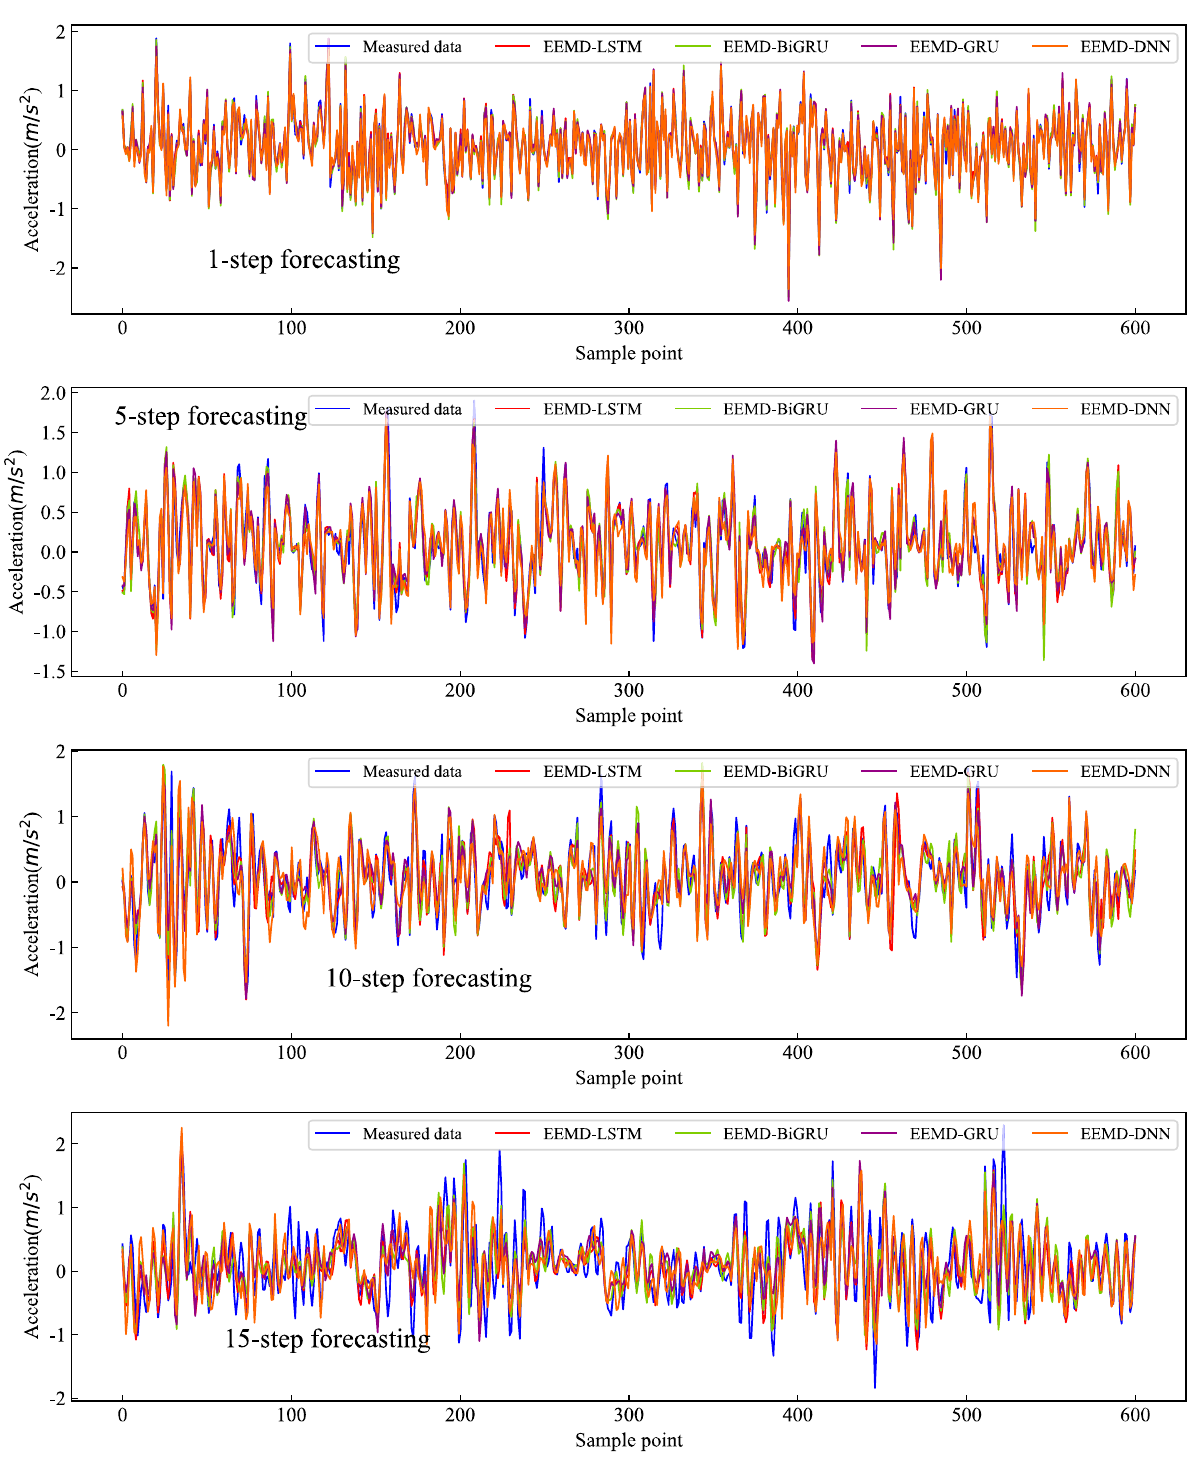
Figure 14. Comparisons results for the white dataset using the EEMD-based algorithms (from top to bottom, the order was 1-step forecasting, 5-step forecasting, 10-step forecasting, and 15-step fore- casting).